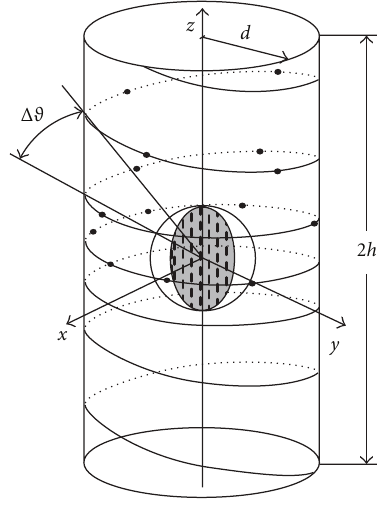
Figure 1: Helicoidal